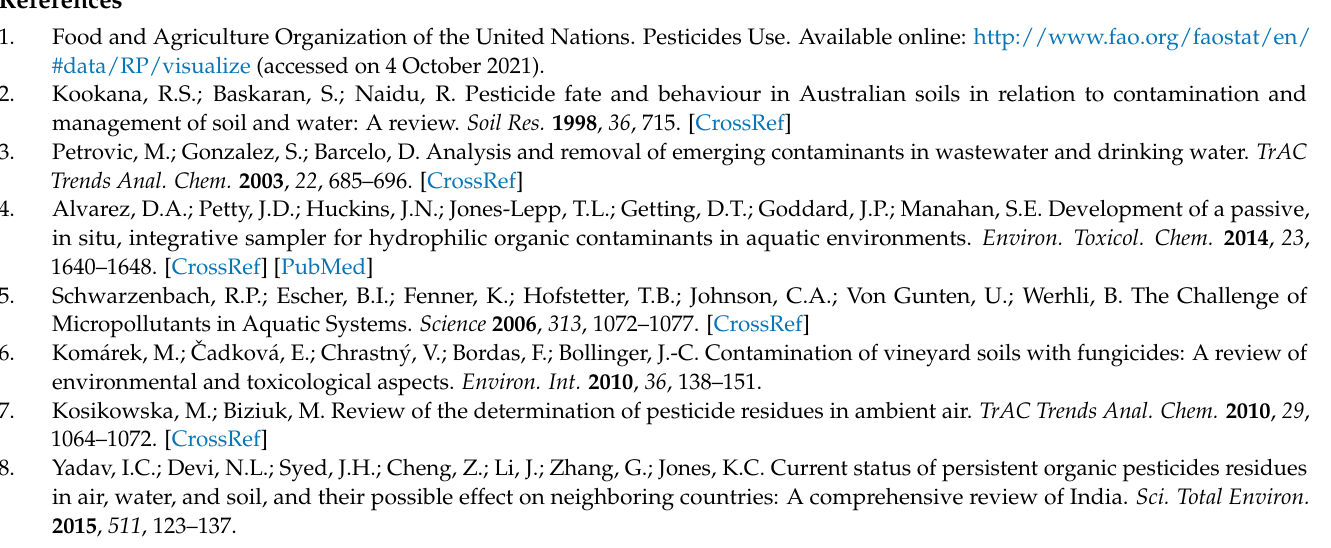
Table S2: Meteorological data during the calibration week; Table S3: LC-MS/MS method conditions and parameters; Table S4: GC-MS/MS method conditions and parameters, Table S5: Method extrac- tion performances for spiked PUF-PAS ( n = 5); Table S6: Concentrations of CUPs (ng PUF-PAS − 1 ) in the 2 sampling sites for the 2 sampling